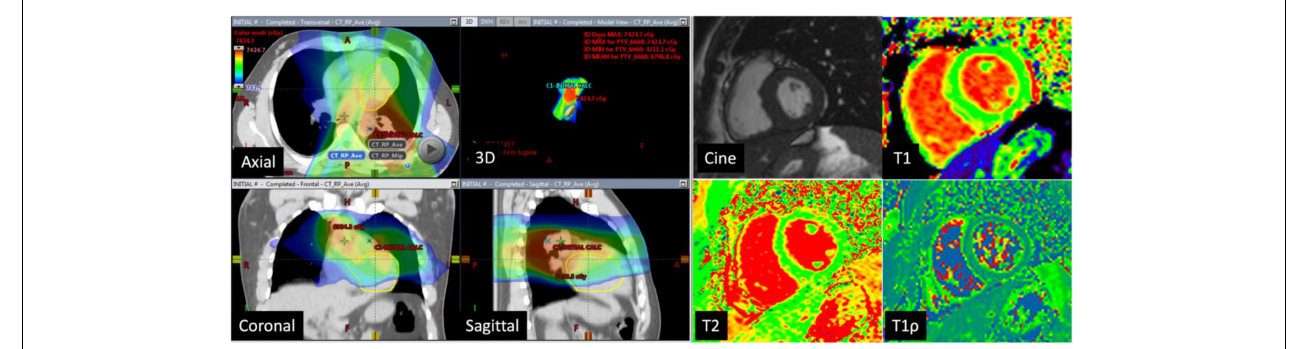
FIGURE 3 | CT images in a 73-year-old man with lung cancer: Axial, coronal, sagittal, and 3D CT images with color-washed dose distribution. The heart depicted in the yellow is in the radiation field. The patient received a total of 66.6 Gy of which the mean dose to the left ventricle was 31.6 Gy. Cardiac magnetic resonance (CMR) images at baseline with normal LVEF (60%), normal native T1 mapping (983 ms), normal T2 mapping (43 ms), and elevated T1 ρ at 87 ms. TABLE 3 | Cardiovascular magnetic resonance (CMR) characteristics pre- and post-RT in different radiation doses to the heart and left ventricle. Variables Absolute change p -Value % Change p -Value Patients with minimal Patients with partial/full Patients with minimal Patients with partial/full radiation ( n = 6) radiation ( n = 5) radiation ( n = 6) radiation ( n = 5) Peak LV GLS